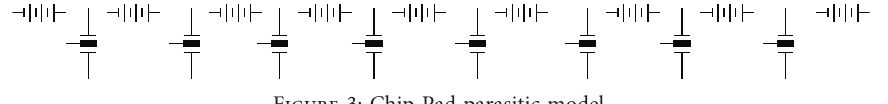
Figure 3: Chip Pad parasitic